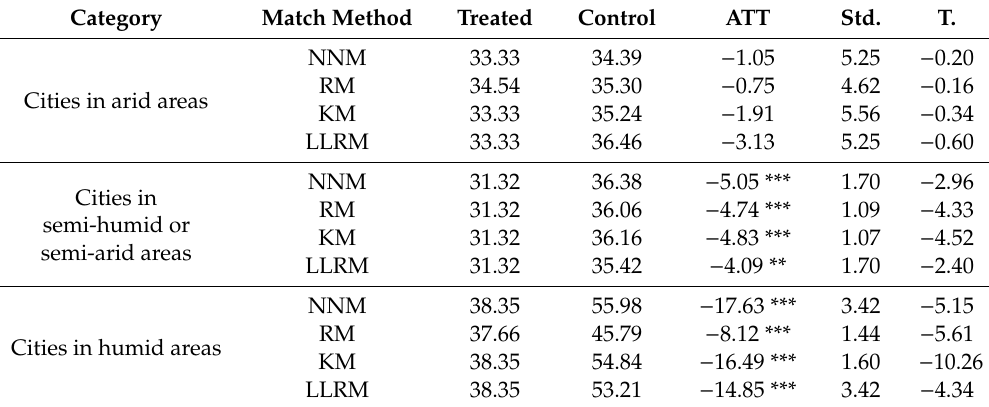
Table 4. ATT estimates in cities with di ff erent water resource endowments.